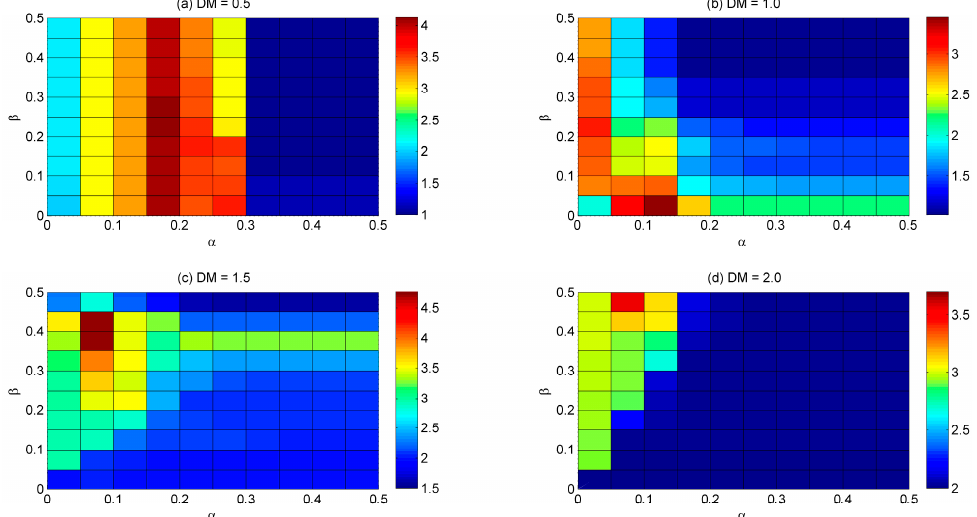
Figure 3. The evolution process of failure propagation time with different DM conditions: ( a ) DM = 0.5; ( b ) DM = 1.0; ( c ) DM = 1.5; ( d ) DM = 2.0.